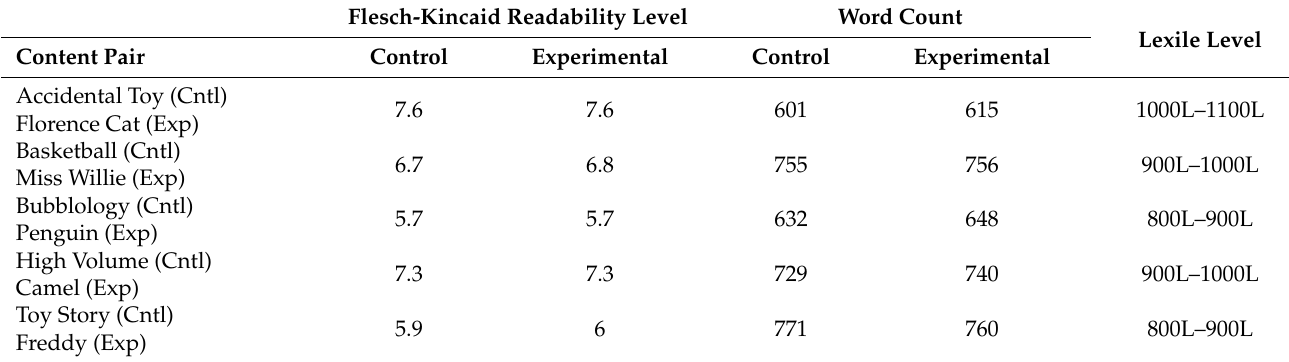
Table 1. Passage Reading Difficulty.